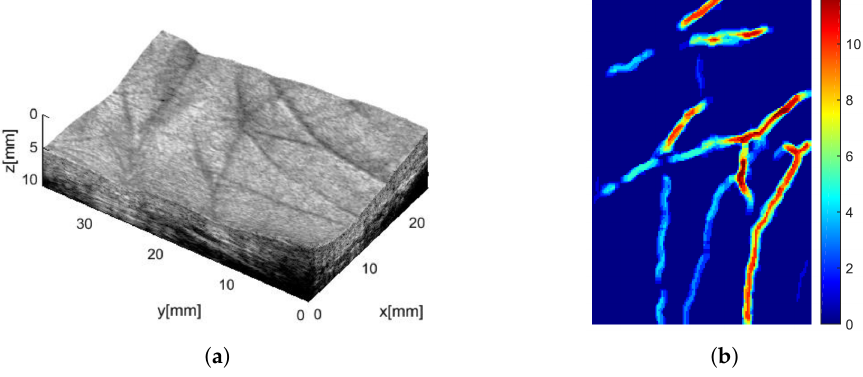
Figure 6. 3D palmprint: ( a ) a 3D render of a human palm where palm curvature can be appreciated and ( b ) 3D template accounting for lines’ depth. Reprinted with permission from